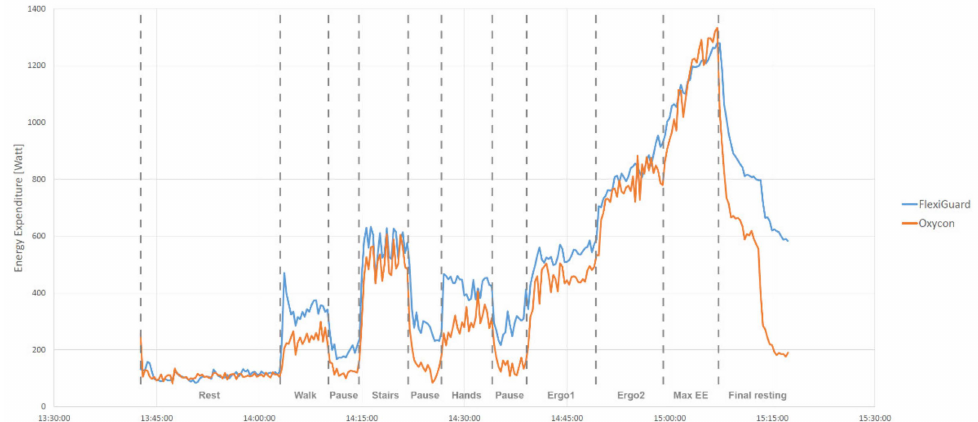
Figure 4. Benchmark of energy expenditure graph for one proband (blue curve—FlexiGuard, orange